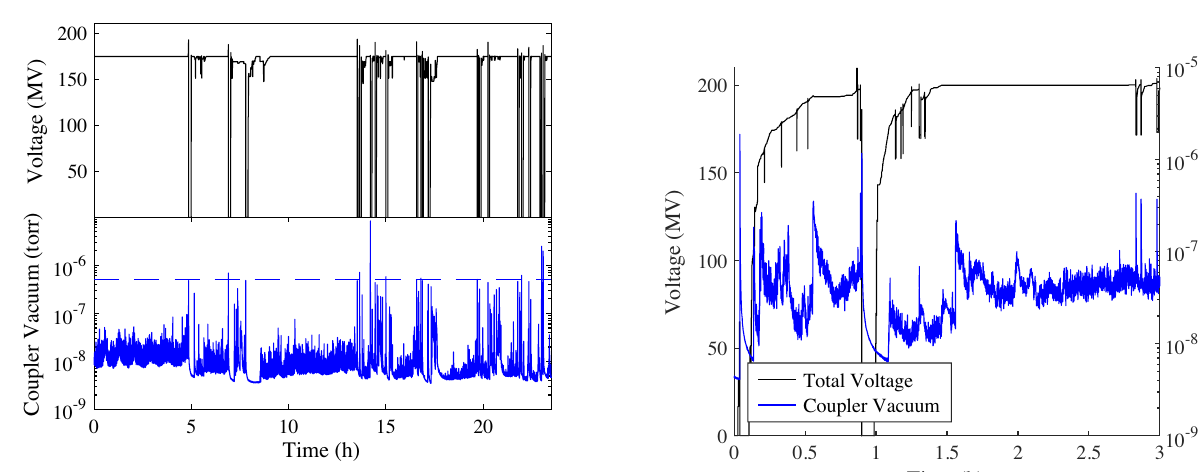
FIG. 20. Data taken during the high gradient test in which a total voltage of 200 MV was maintained for more than one